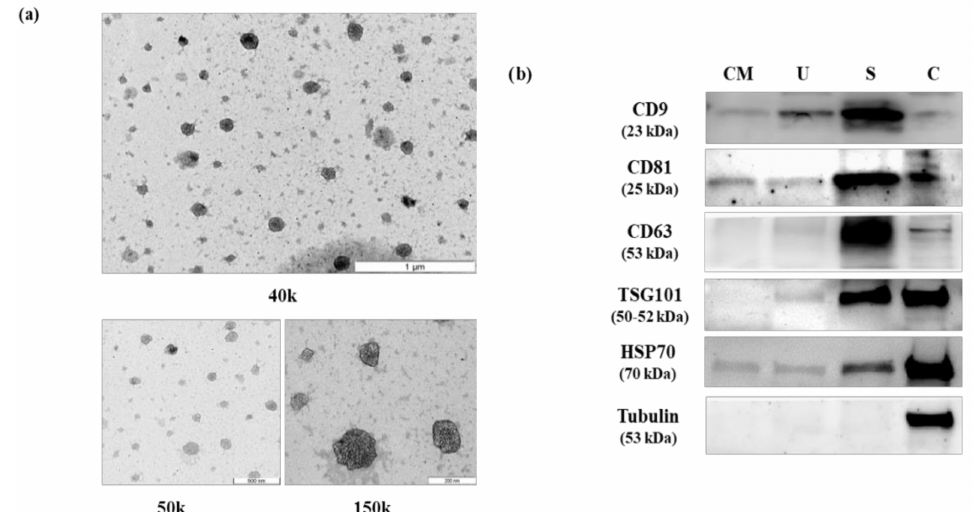
Figure 1. Characterization of isolated extracellular vesicles. ( a ) Analysis of extracellular vesicles (EVs) by electron microscopy at different magnification. ( b ) Western blot image of protein extracts prepared from EVs isolated from PC-3 culture media (CM), post-digital rectal examination urine (U), semen (S) and total cell extract from PC-3 (C), and tested with the following antibodies: CD9, CD81, CD63, TSG101, HSP70 and tubulin. Uncropped Western Blot image is available in Figure S1.